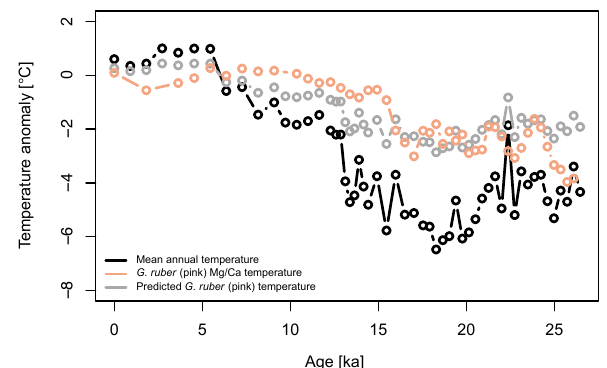
Figure 9. Effect of habitat tracking: reduced magnitude of deglacial temperature change estimated from Mg / Ca of G. ruber (pink; El- derfield and Ganssen, 2000) compared to faunal assemblage based seasonal temperature estimates (Chapman et al., 1996) in the sub- tropical North Atlantic. The predicted G. ruber (pink) temperature, which is similar to the Mg / Ca temperature, is based on the rela- tionship identified in Fig. 2 and the assemblage-derived tempera- tures. Values are anomalies with respect to the 0–10000 years BP